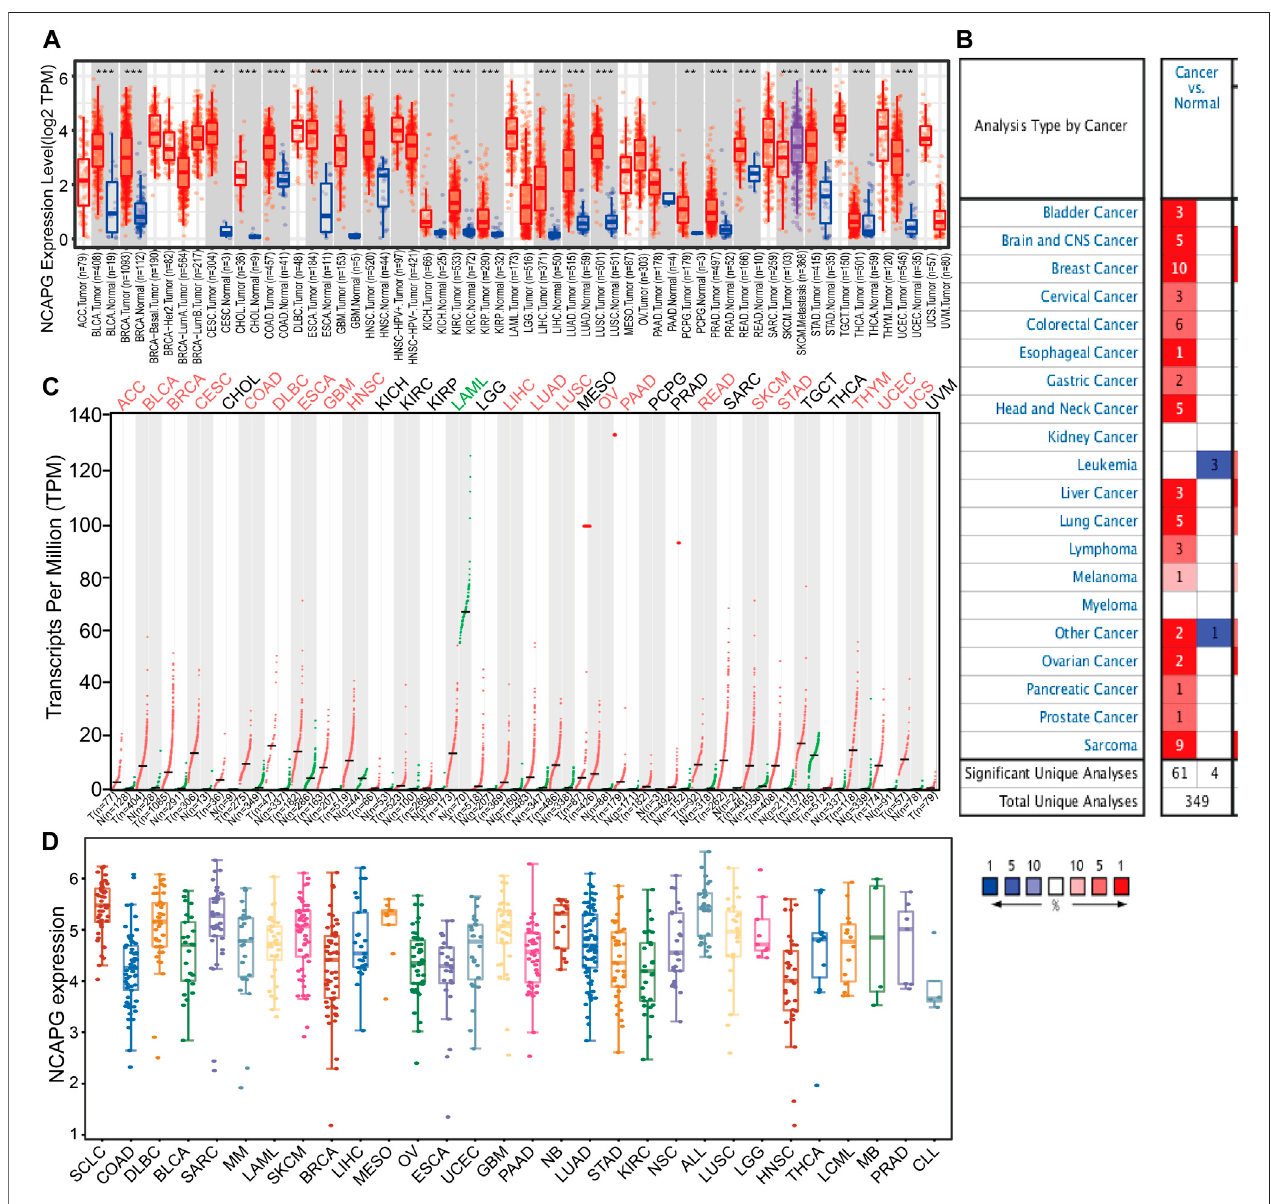
FIGURE1| ExpressionanalysisforNCAPGinhumancancers (A) NCAPGexpressionofdifferenttumortypesinpan-cancerexaminedbytheTIMERdatabase. (B) IncreasedexpressionofNCAPGinpan-cancerexaminedbytheOncominedatabase. (C) NCAPGexpressioninpan-cancerexaminedbyTCGAandGTExdata. (D) The expression of NCAPG in different tumor cells lines was examined by the CCLE database. * p < 0.05, ** p < 0.01, *** p <